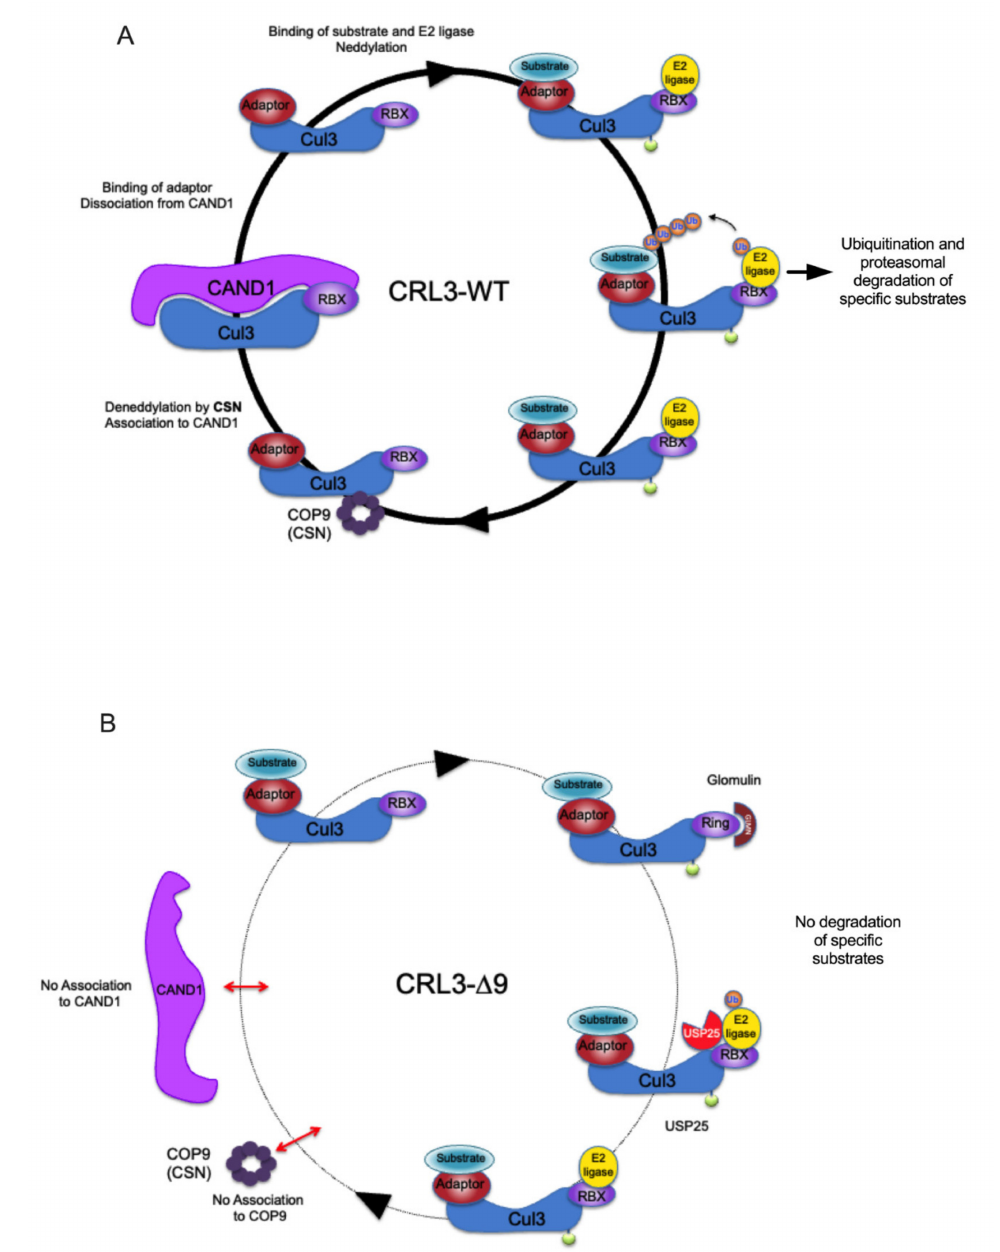
Figure 9. Hypothetical model of the functional defects of CUL3- ∆ 9 CRL complex. ( A ). Classical model of CRL3 cycling. The different partners of the CRL3 cycle are indicated. The Cul3-Rbx1/CAND1 complex is inactive (left). Its dissociation allows the binding of adaptor and substrate and the neddy- lation of CUL3. This potentially active complex binds an E2 ligase and ubiquitinates the substrate, leading to the degradation by the proteasome. After substrate ubiquitination, the CRL3 complex interacts with the COP9 signalosome, resulting in the deneddylation of CUL3. The dissociation from the adaptor allows the re-association with CAND1. The different partners of the CRL cycle are indicated. ( B ). In the presence of CUL3- ∆ 9, the CRL3 is unable to bind to COP9 (CSN4) and therefore to be deneddylated and to bind to CAND1. This interrupts the CRL3 cycle, which is essential for